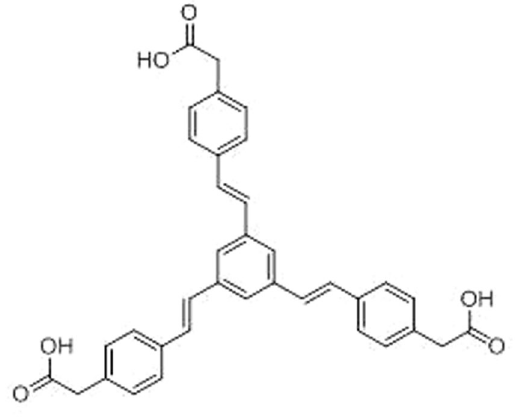
Figure 1. Structure of compound 135C